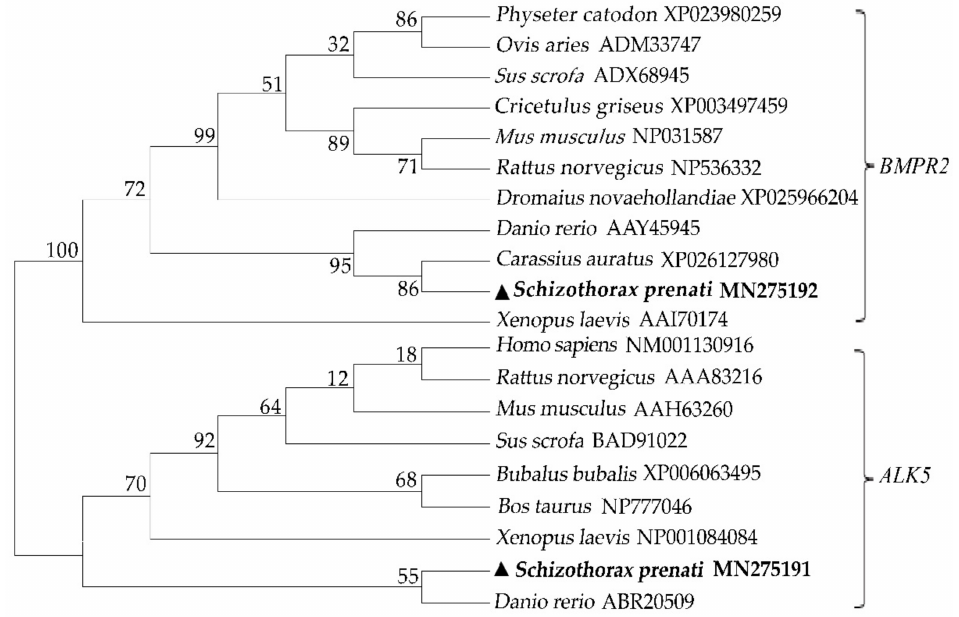
Figure 1. Phylogenetic analysis of ALK5 and BMPR2 with those of other vertebrates. The ALK5 and BMPR2 sequences of the other vertebrates were downloaded from Entrez (NCBI). The phylogenetic tree was analyzed using the neighbor-joining algorithm of Mega 7.0. The numbers at the forks are the bootstrap proportions. S. prenanti is marked with black